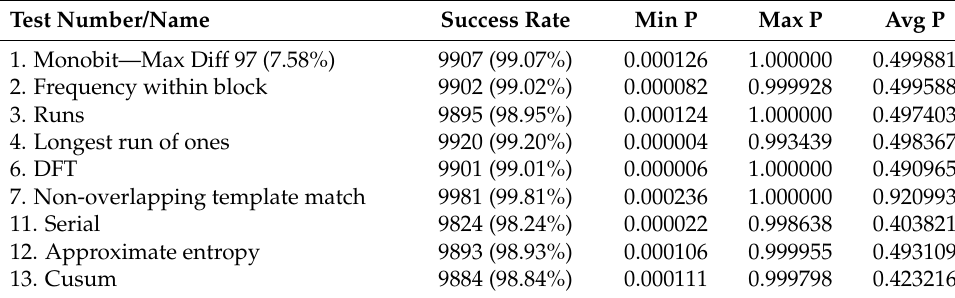
Table 3. Test results for the first variant random (10,000 samples